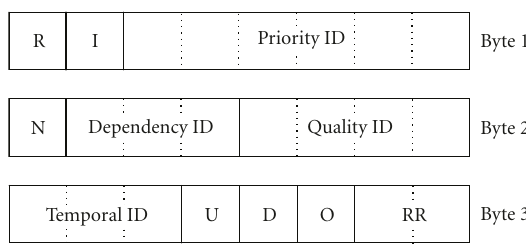
Figure 1: Additional bytes in SVC NAL unit